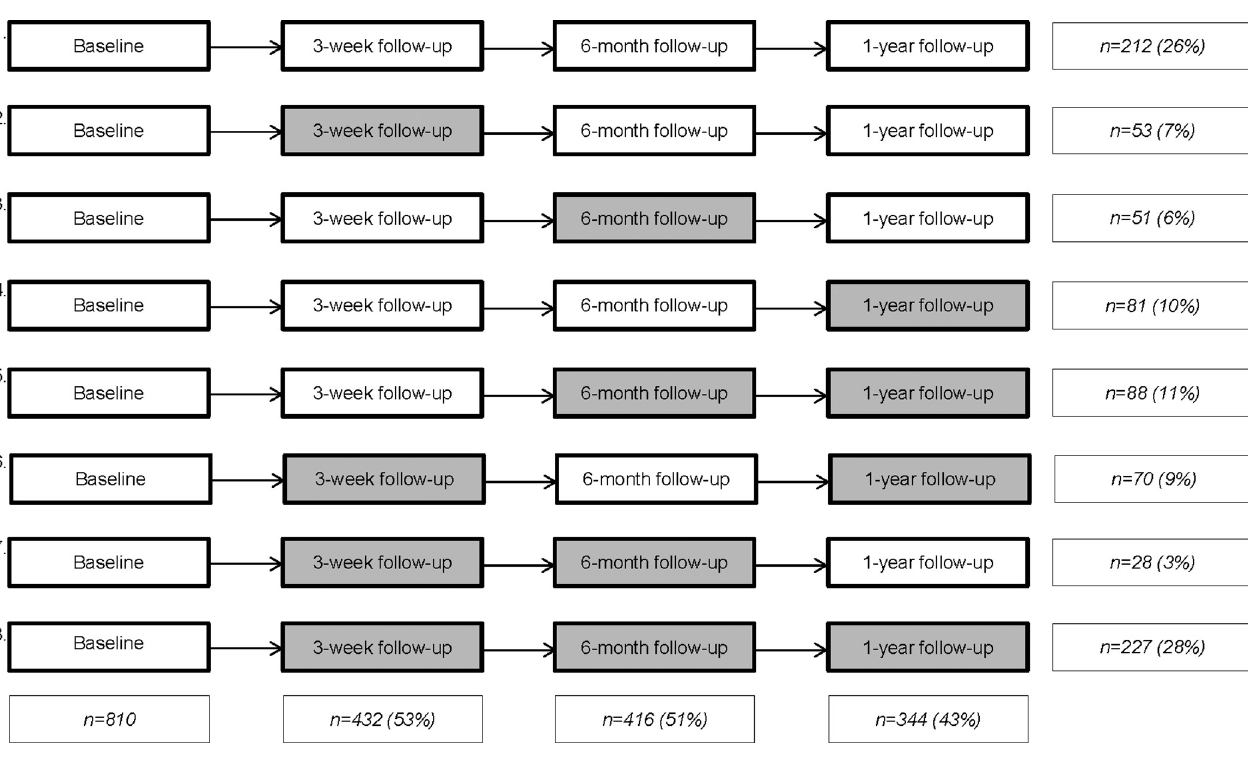
Fig 2. Response participants invited for follow-up, at three-week, six-month, and one-year follow-up. Grey indicates (partial) lost to follow-up.